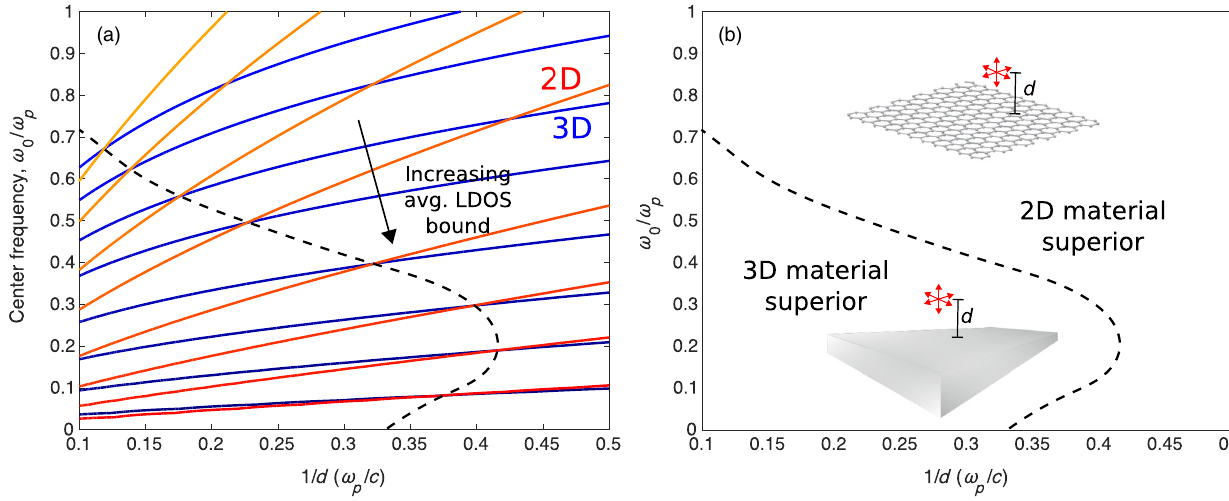
FIG. 6. Comparison of average LDOS bounds for Drude-like 3D and 2D materials with identical decay constants ω p and material loss rates γ ¼ 0 . 01 ω p . (a) Isocurves of the average LDOS bound, which increase as both center frequency and distance decrease. (b) For a small enough emitter-scatterer distance d , 2D materials are clearly superior, whereas for modest center frequencies and larger distances, 3D materials exhibit a larger maximum response. Such behavior arises from the fact that the bounds for 2D materials scale as 1 =d 4 , in contrast to 1 =d 3 scaling for bulk materials. The dotted curve delineates the regions within which 3D or 2D materials are superior. The bandwidth-to-center-frequency ratio Δ ω = ω 0 is set to